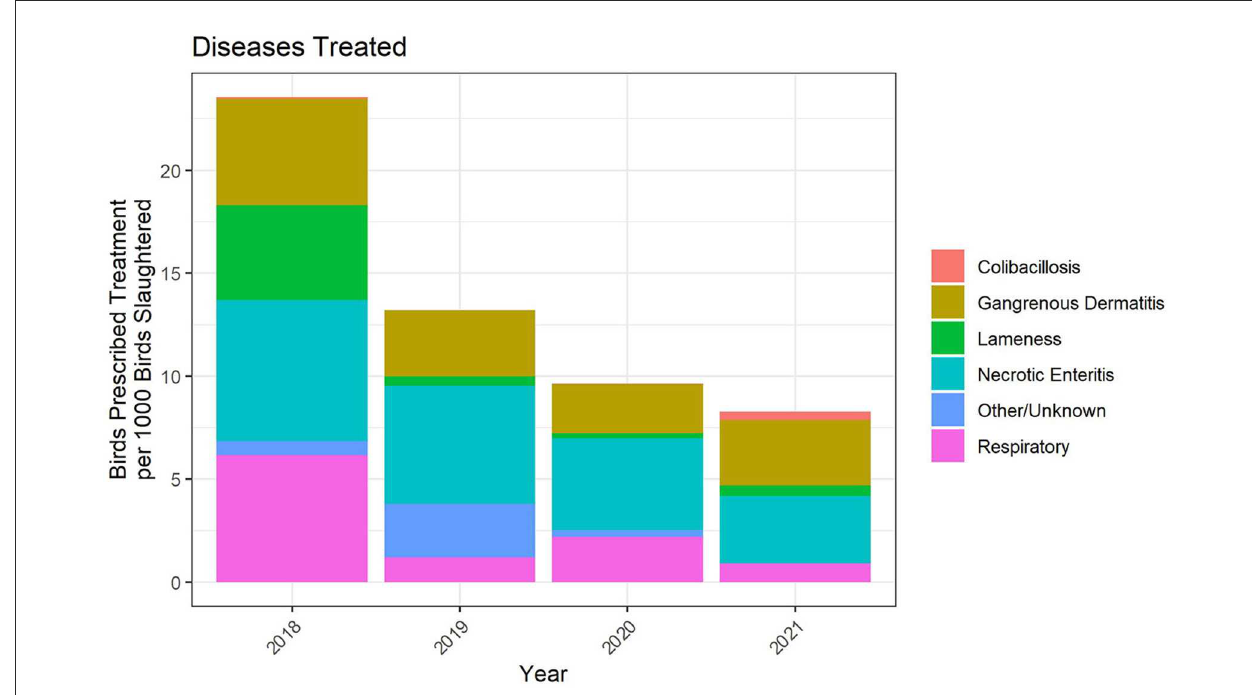
FIGURE7 Disease indications treated with water-soluble antimicrobial administrations, 2018–2021. The figures depict the number of birds prescribed treatment for each disease indication per 1,000 birds slaughtered.